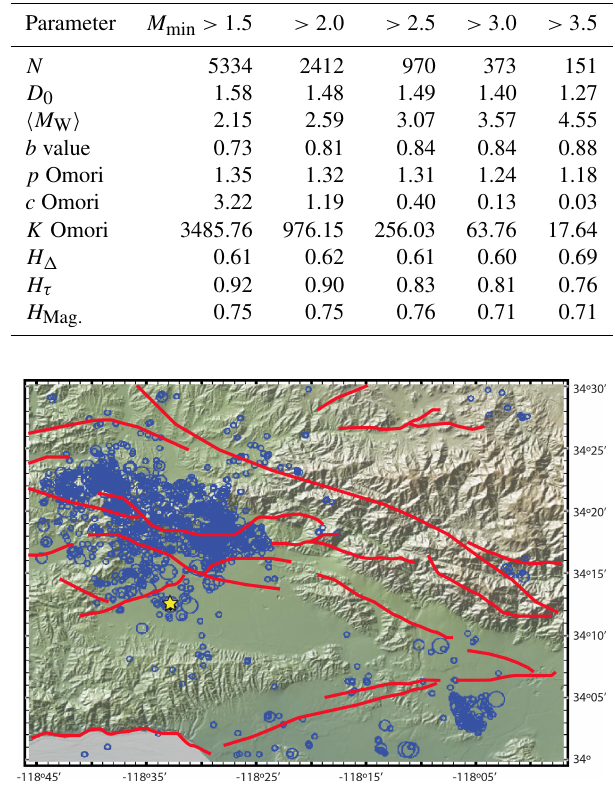
Figure 2. Map that includes the seismicity of magnitude larger than 2.0 during 1981–2006. The yellow star indicates the Northridge epi- center ( M W 6 . 7, 1994). Red lines depict the faults of this region considering an approximated area of 0.6 ◦ × 0.6 ◦ . Blue circles indi- cate aftershock locations and the size of their